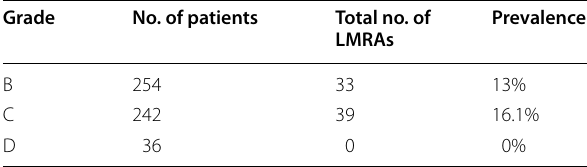
Table 3 Prevalence of LMRA in male and female patients Gender